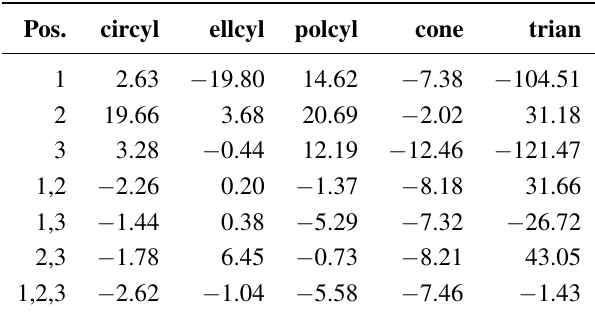
Table 2. Effect of the number of scanning positions for Stem Model 7. First column: included scanning directions. Others: relative volume error